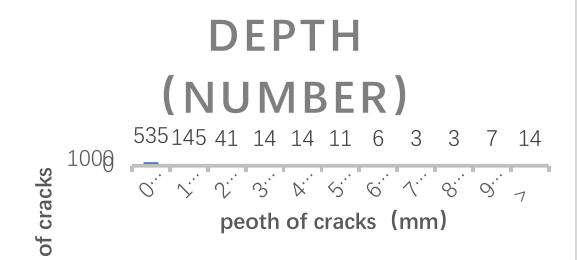
Figure 14. The three section of the cracks’ length.